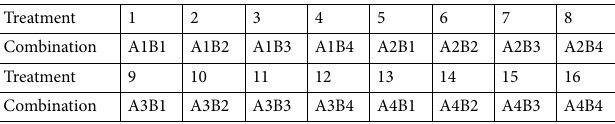
Table 1. The combinations of test treatments.